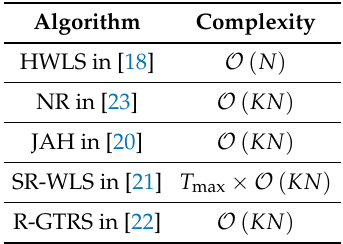
Table 1. Summary of the Considered